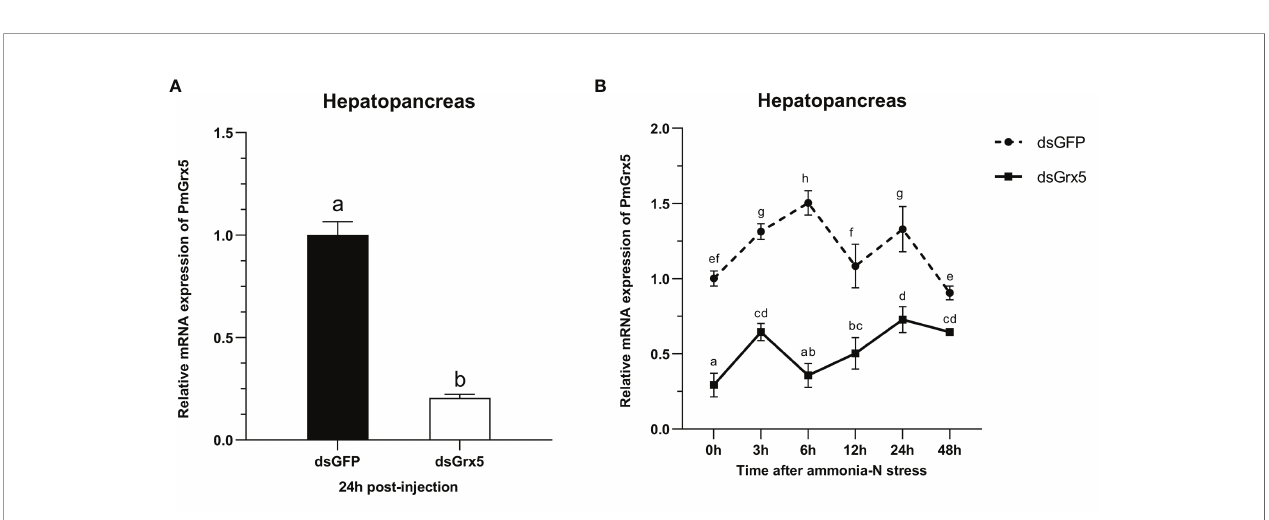
FIGURE 7 | mRNA expression levels of PmGrx5 in the hepatopancreas (A) and gill (B) at different time intervals under different concentrations of ammonia-N stress. The data are presented as mean ± SD ( n = 3). Different letters denote signi fi cant differences ( P <